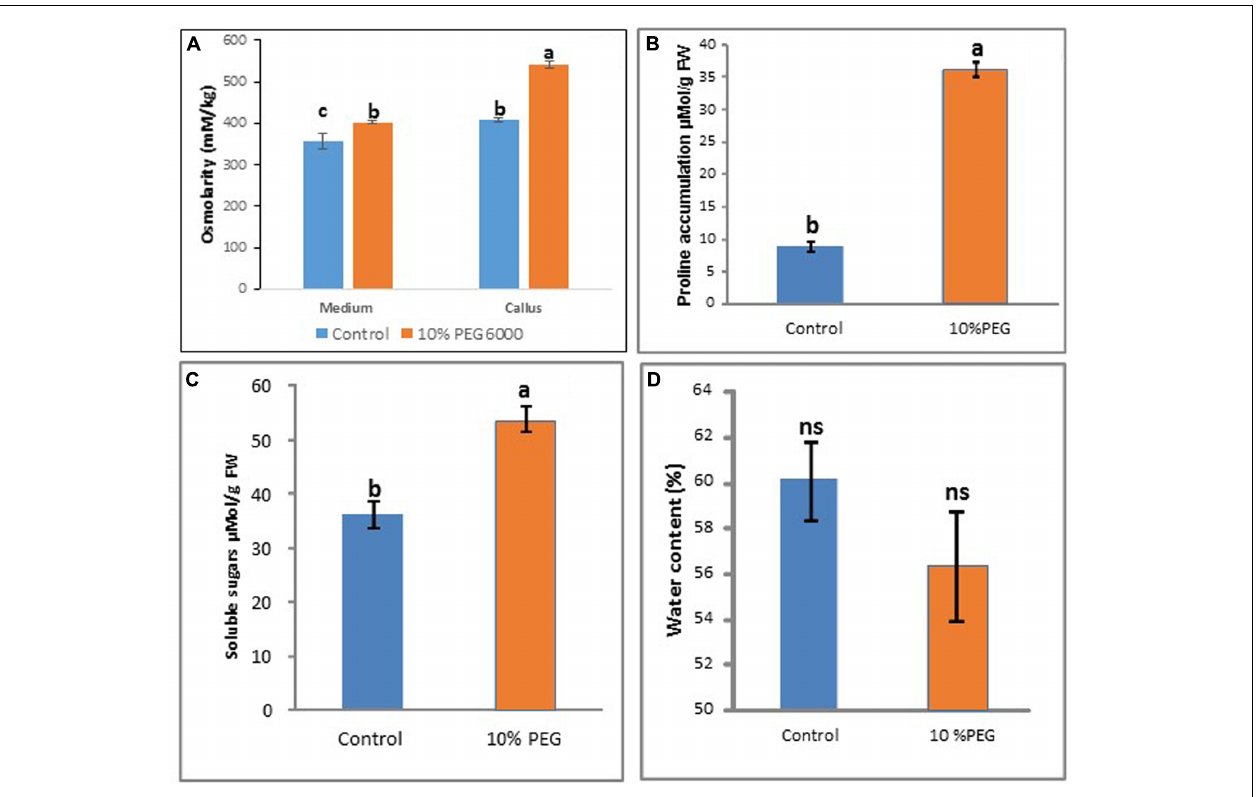
FIGURE 5 | Comparisons between control and 10% PEG treatments after 6 months in vitro culture in terms of: (A) medium and callus osmolarity, (B) proline content, (C) soluble sugars, and (D) water content. Note different letters indicate significant differences ( P ≤ 0.05) between treatments ( n = 3 ± SD); ns, non-significant. [Kruskall–Wallis followed by Dunn’s test (A) ; Wilcoxon signed rank test (B); and Welch Two Sample t -test (C,D) ]. See Supplementary File S5 for data and statistical